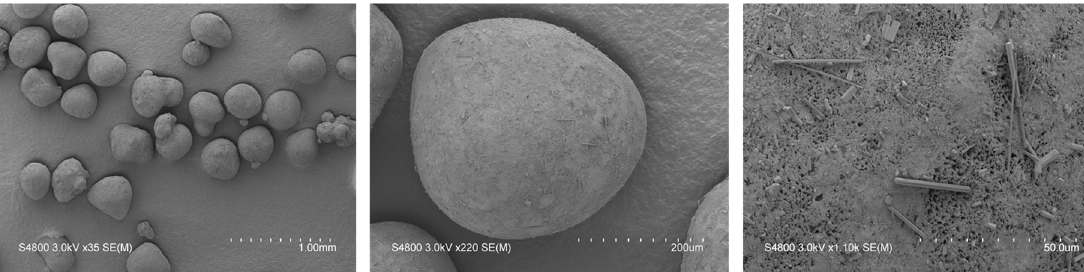
Figure 13. SEM pictures of NAM pellets produced by spray granulation.